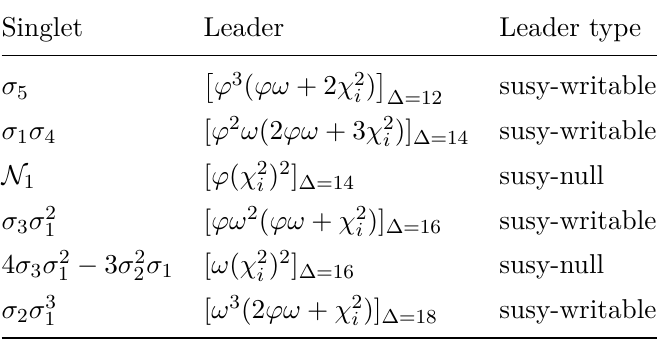
Table 5 . Scalar leaders with N φ = 5 , N der = 0 in d = 8